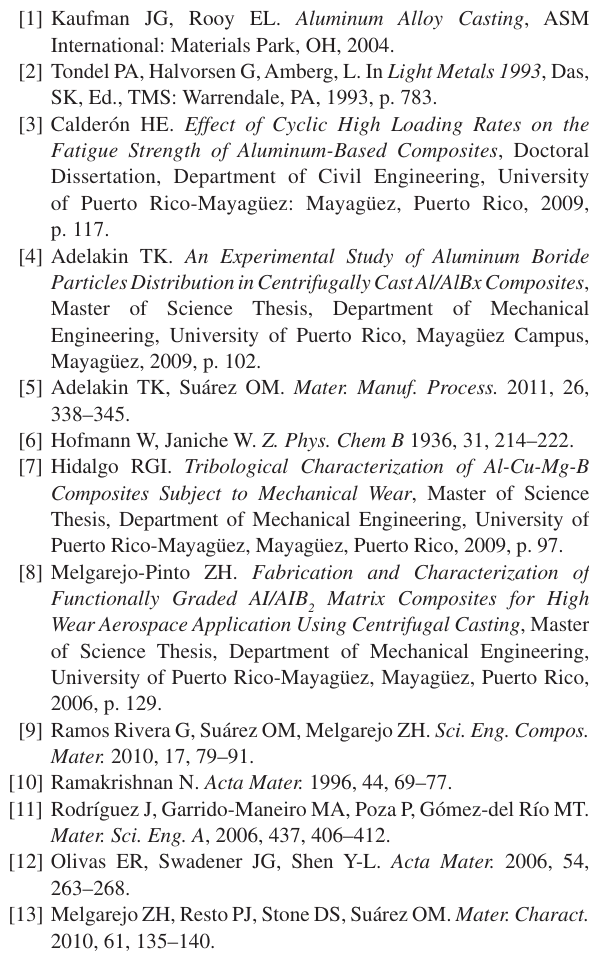
Figure 9 Nanoindentation load vs. displacement curves on AlB particles and the aluminum matrix of both and AlB 12